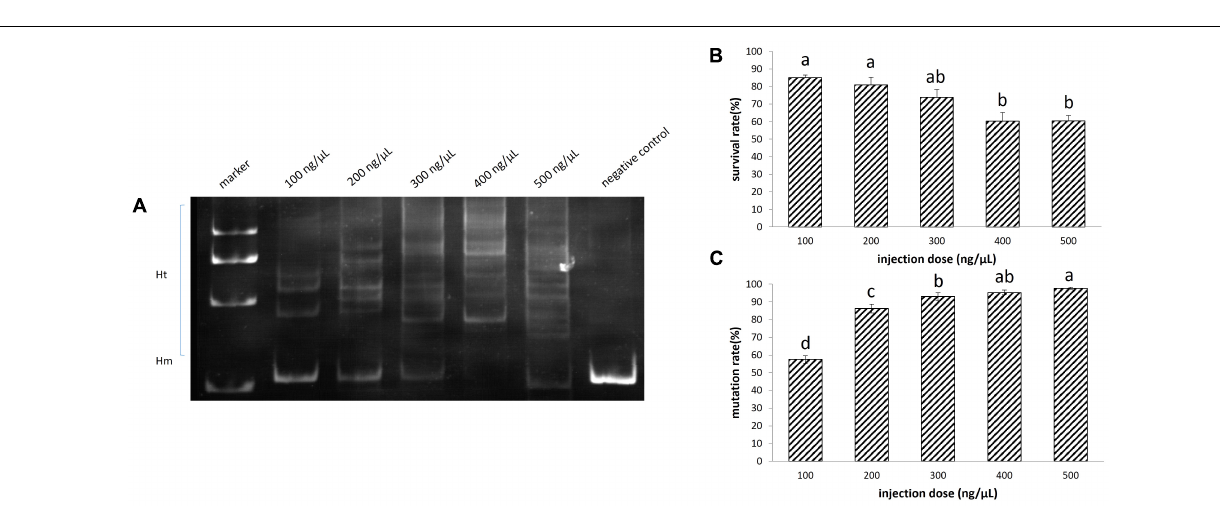
FIGURE 3 | Disruption of EGFP by transcription activator-like effector nucleases (TALENs) in sterlet. A total of 532 embryos were injected. (A) Detection of mutation by PAGE. (B) Survival rate of injected embryos. (C) Mutation rate at target site. The survival rate and mutation rate were transformed to arcsine square root, then analyzed by ANOVA followed by Student–Newman–Keuls method. Symbols with the same indicate groups that are not significantly